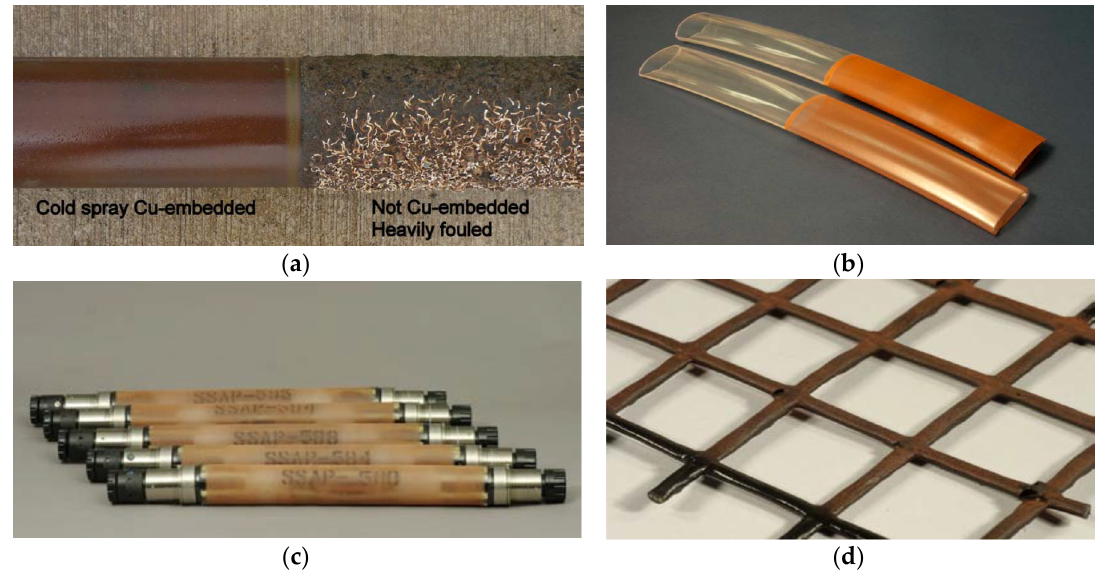
Figure 22. Photographs of ( a ) comparsion of Cu embedded and with Cu-embedded in streamer skin; ( b ) Cu coating on polyurethane; ( c ) Cu embedded on cables; ( d ) Cu embedded on the net for fish farms [66–68].